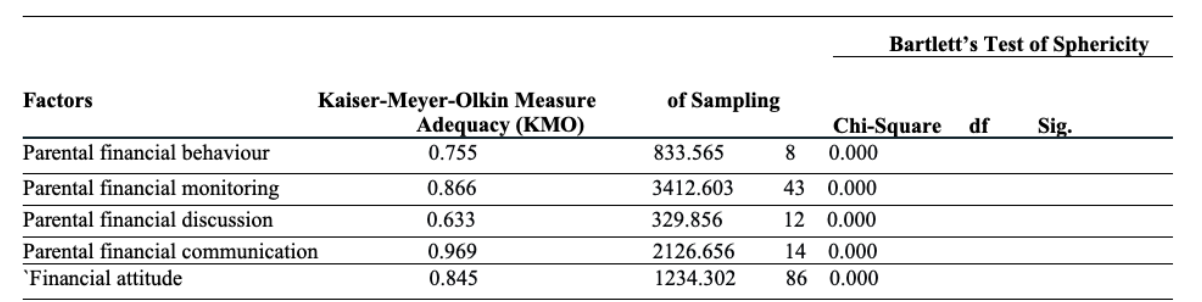
Table 1: KMO and Bartlett’s Test